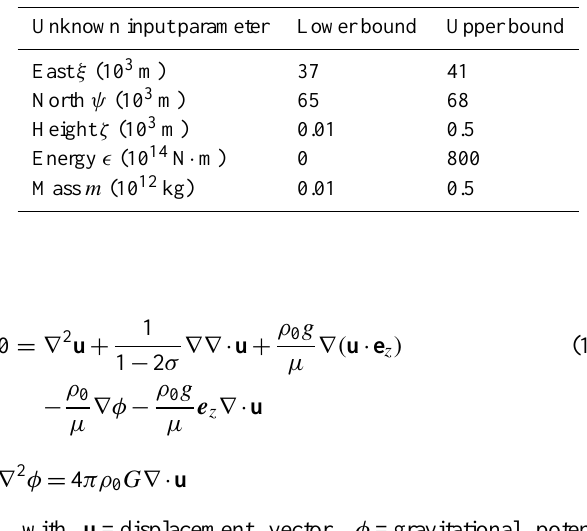
Table 1. Range limitations for the input parameters used for the